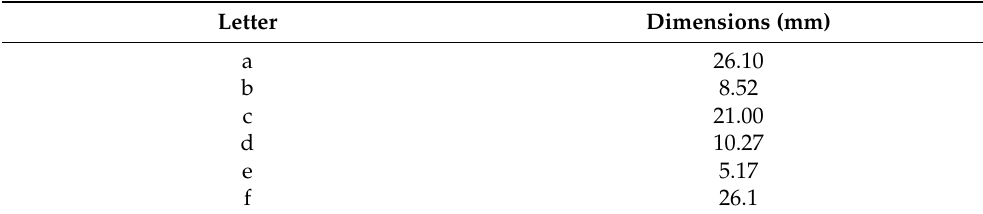
Figure 3. MG. ( a ) Schematic diagram. ( b ) PRBM and lengths of the linkage elements. ( c ) Angular and instantaneous velocities. ( d ) Rotational springs. Table 3. Rigid linkage elements